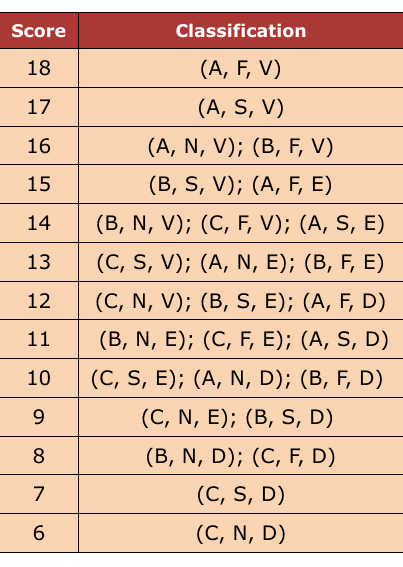
Table 5. Distinct priority levels for all three classifications